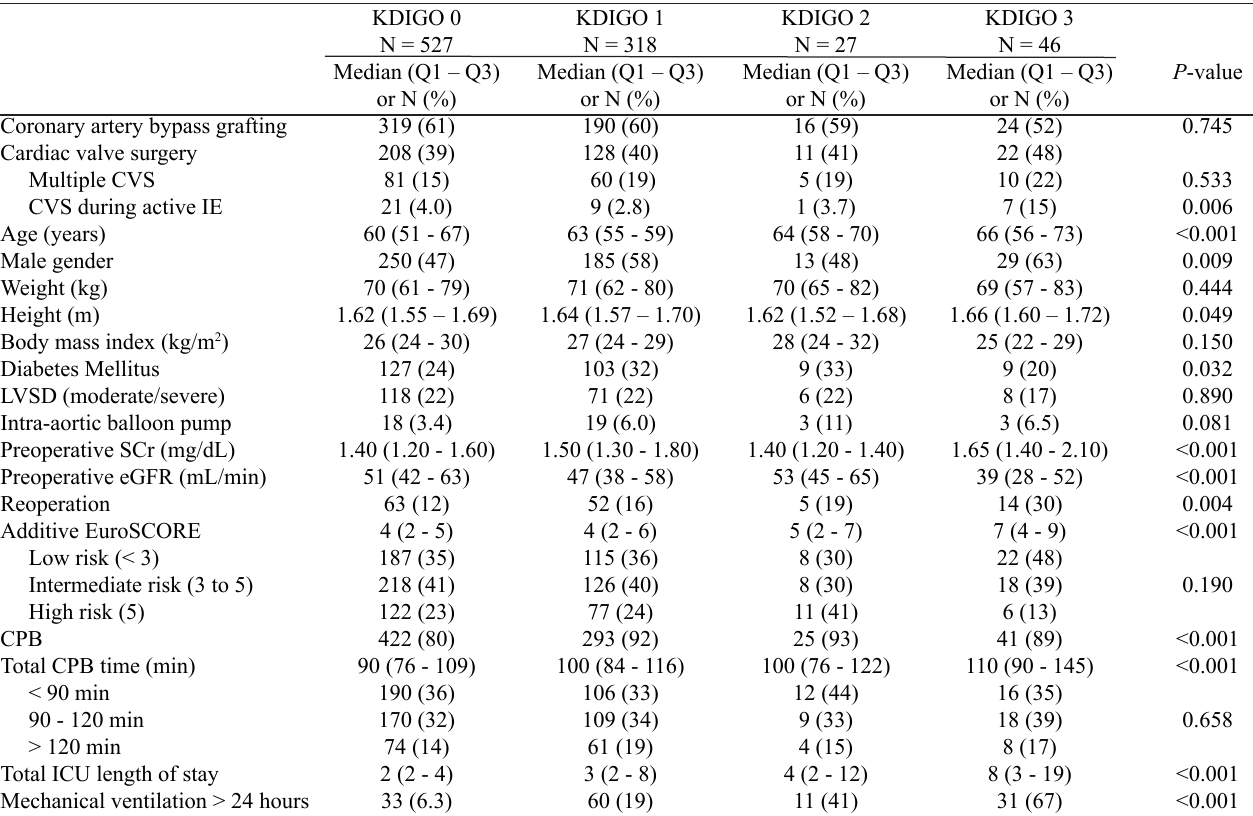
Table 5. Demographic data of patients who underwent cardiac surgery based on the KDIGO